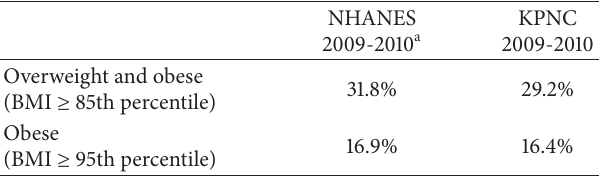
Table6:KPNCcountiesversusKPNCforchildhoodandadolescent overweight and obesity in 2005 and